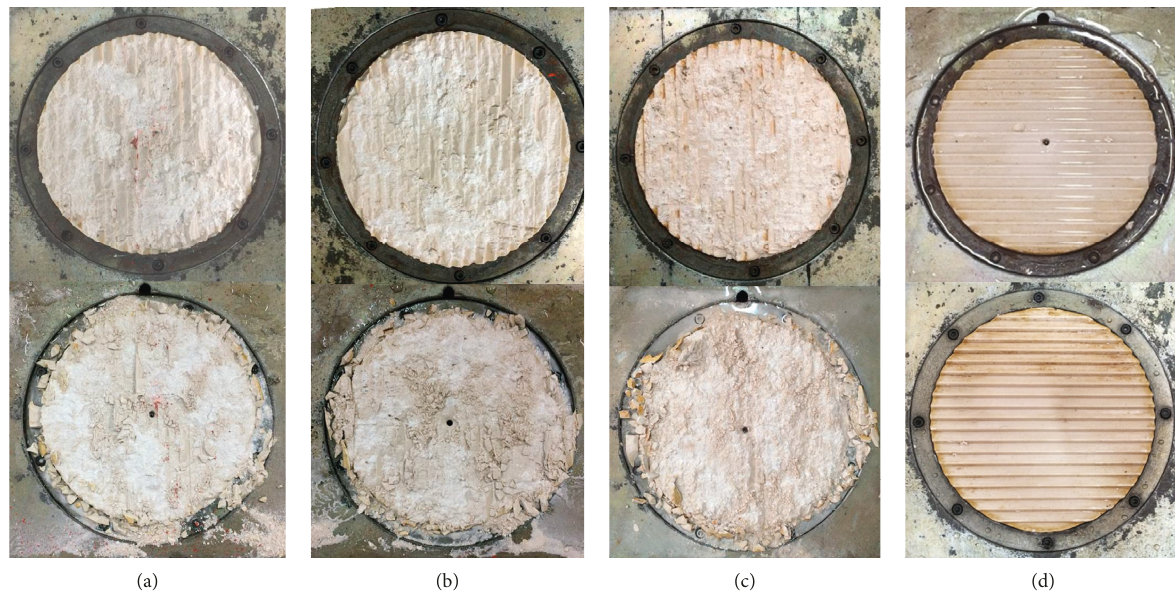
Figure 10: Group C fracture surfaces after the shear tests. (a) Case 6. (b) Case 7. (c) Case 2. (d) Case